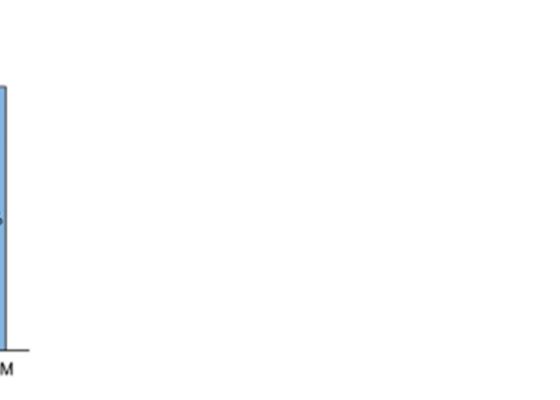
Figure 54. ( a ) Production rate of H 2 with and without visible light. ( b ) Action spectrum and UV- vis spectrum of Rh/TiO 2 . ( c ) Arrhenius plot constructed using the production rate. Reprinted with permission from [72]. Copyright (2018), American Chemical Society.